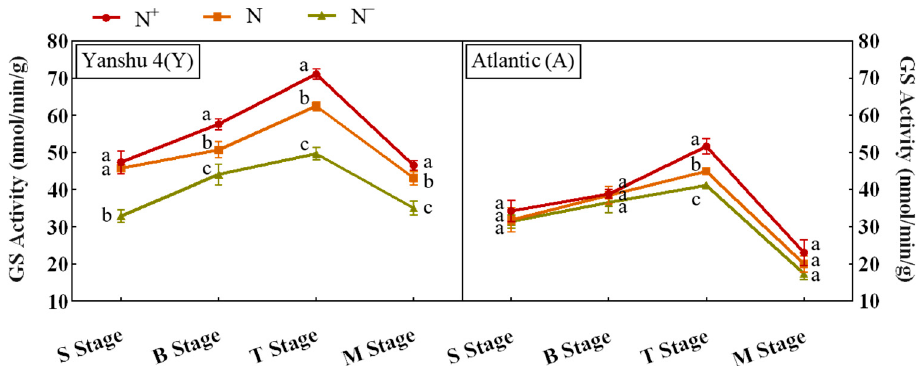
Figure 17. Glutamine synthase (GS) activity in two genotypes of potato leaves under different N supply levels. The amount of 1 nmol of γ -glutamyl hydroxamic acid is produced per 1 mL of reaction system per 1 min per 1 g of fresh weight sample is one unit of enzyme activity. S Stage, B Stage, T Stage, and M Stage represent seedling stage, budding stage, tuber expansion stage, and mature stage, respectively. N − , N, N + are different N supply levels, representing low N, normal N, and excess N, respectively. Different letters indicate the difference of enzyme activity under different N application levels in the same period (p < 0.05).